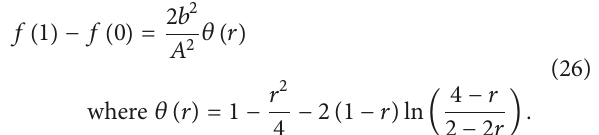
Figure 4: The plot of ℎ(𝑥) . When 𝑟 is almost exactly equal to 𝑟 ∗ , the probability that cooperators will fix is approximately 𝑟 ∗ /4 ≈ 0.2 , regardless of the starting frequency of cooperators, as group size